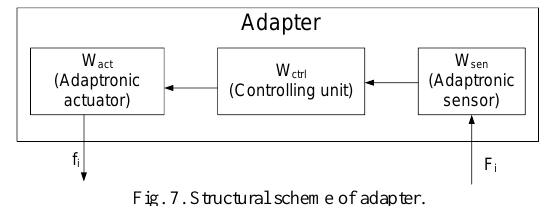
Fig. 7. Structural scheme of